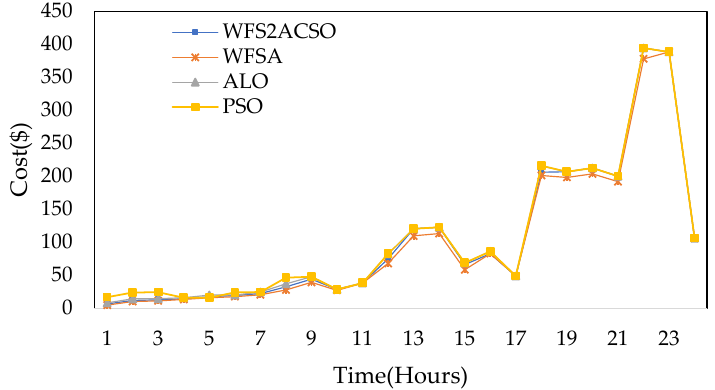
Figure 14. Cost comparison of various techniques for residential area.